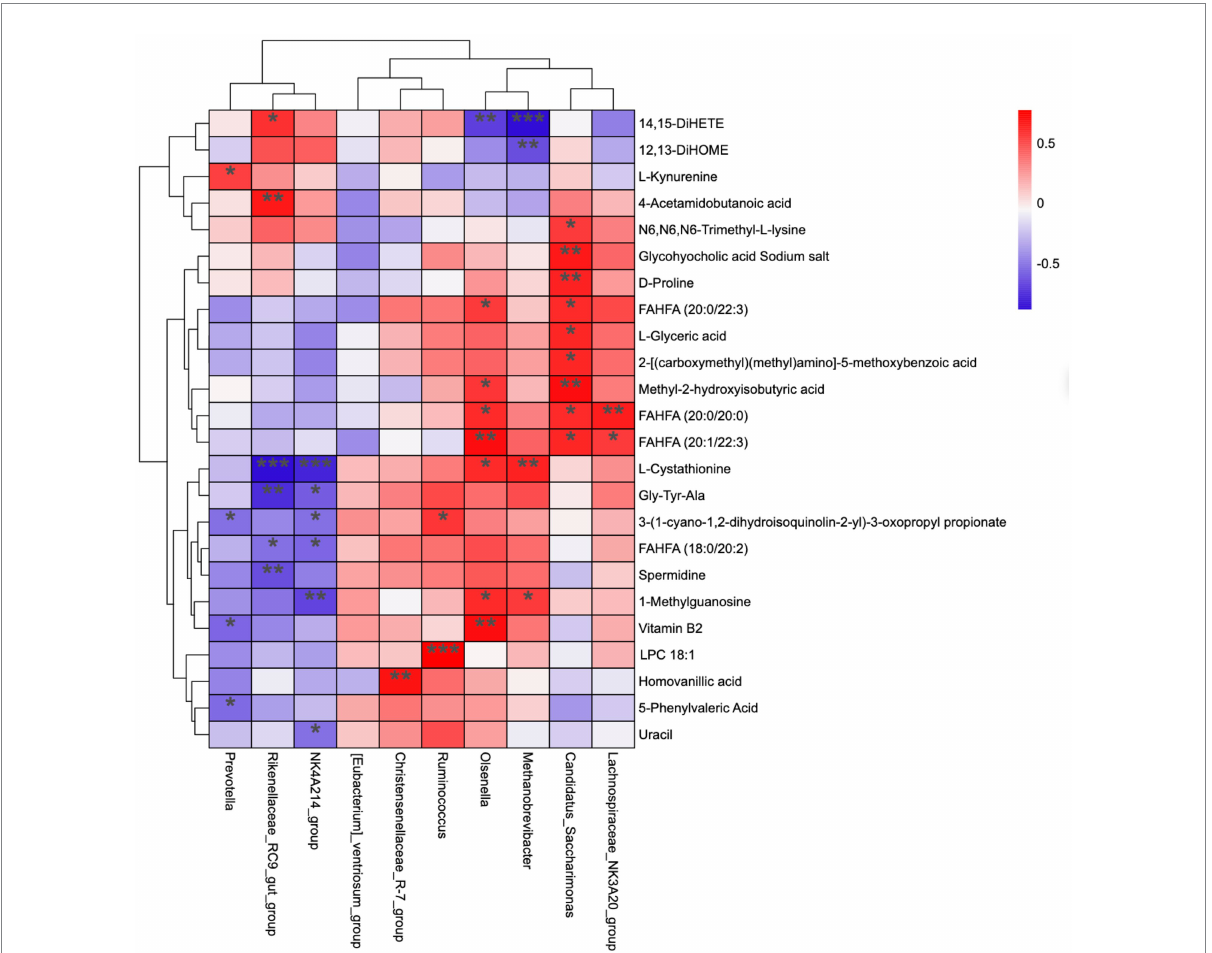
FIGURE 5 Correlation matrix between genus level and rumen differential metabolites. Each row in the figure represents a metabolite, each column represents a genus, and each lattice represents the Pearson correlation coefficient between metabolite and genus levels. Red color indicates positive correlation, while blue color indicates negative correlation. * p < 0.05; ** p <